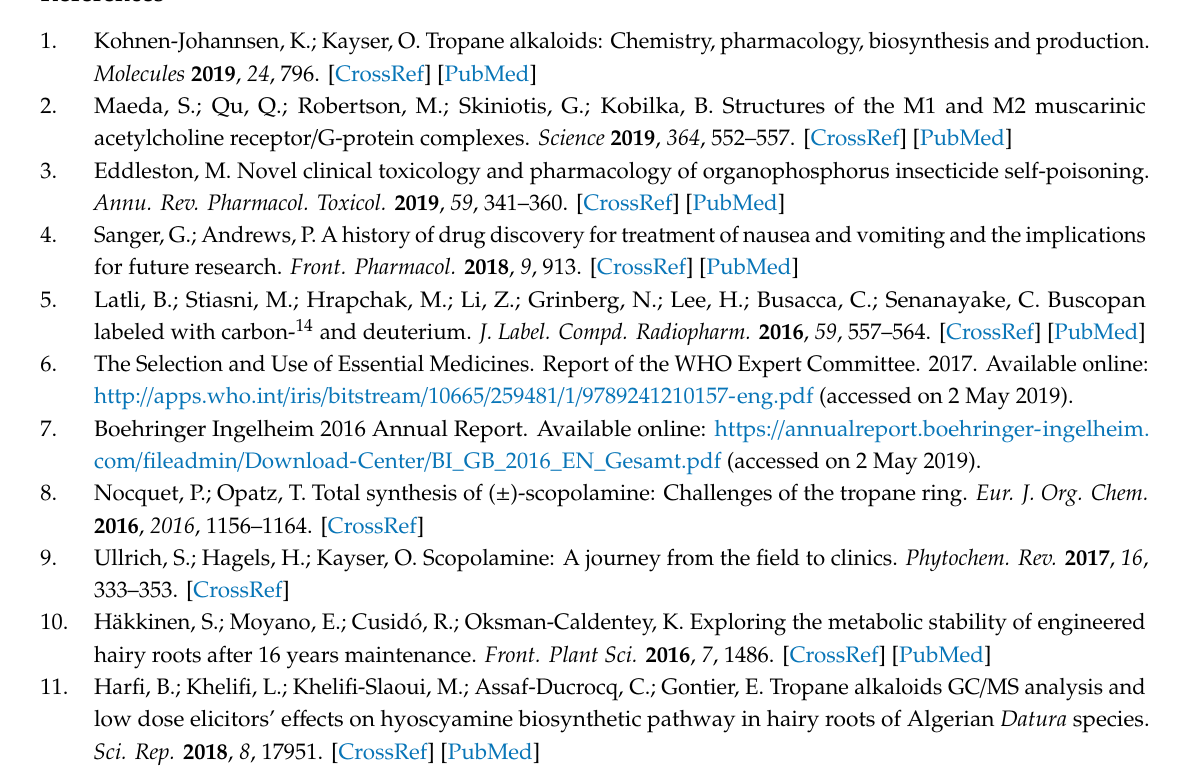
Figure S1: Water tension in the soil used to grow Datura stramonium . (a) tensiometer readings. (b) greenhouse air relative humidity. (c) Greenhouse temperature ( ◦ C). The period shown (3 days) is representative of the curves recorded during the entire period of cultivation. Mass Bank accession records for the MS 2 spectra, Table S1: MetFamily output for MS2 spectra clustering, Table S2: Absolute concentration of atropine and scopolamine calculated from multiple reaction monitoring (MRM) mass spectrometry, Table S3: LC-qToF parameters used to obtain MS2 data, Table S4: Total yield per organ for predicted aromatic tropane alkaloids. Values correspond to ion intensities by